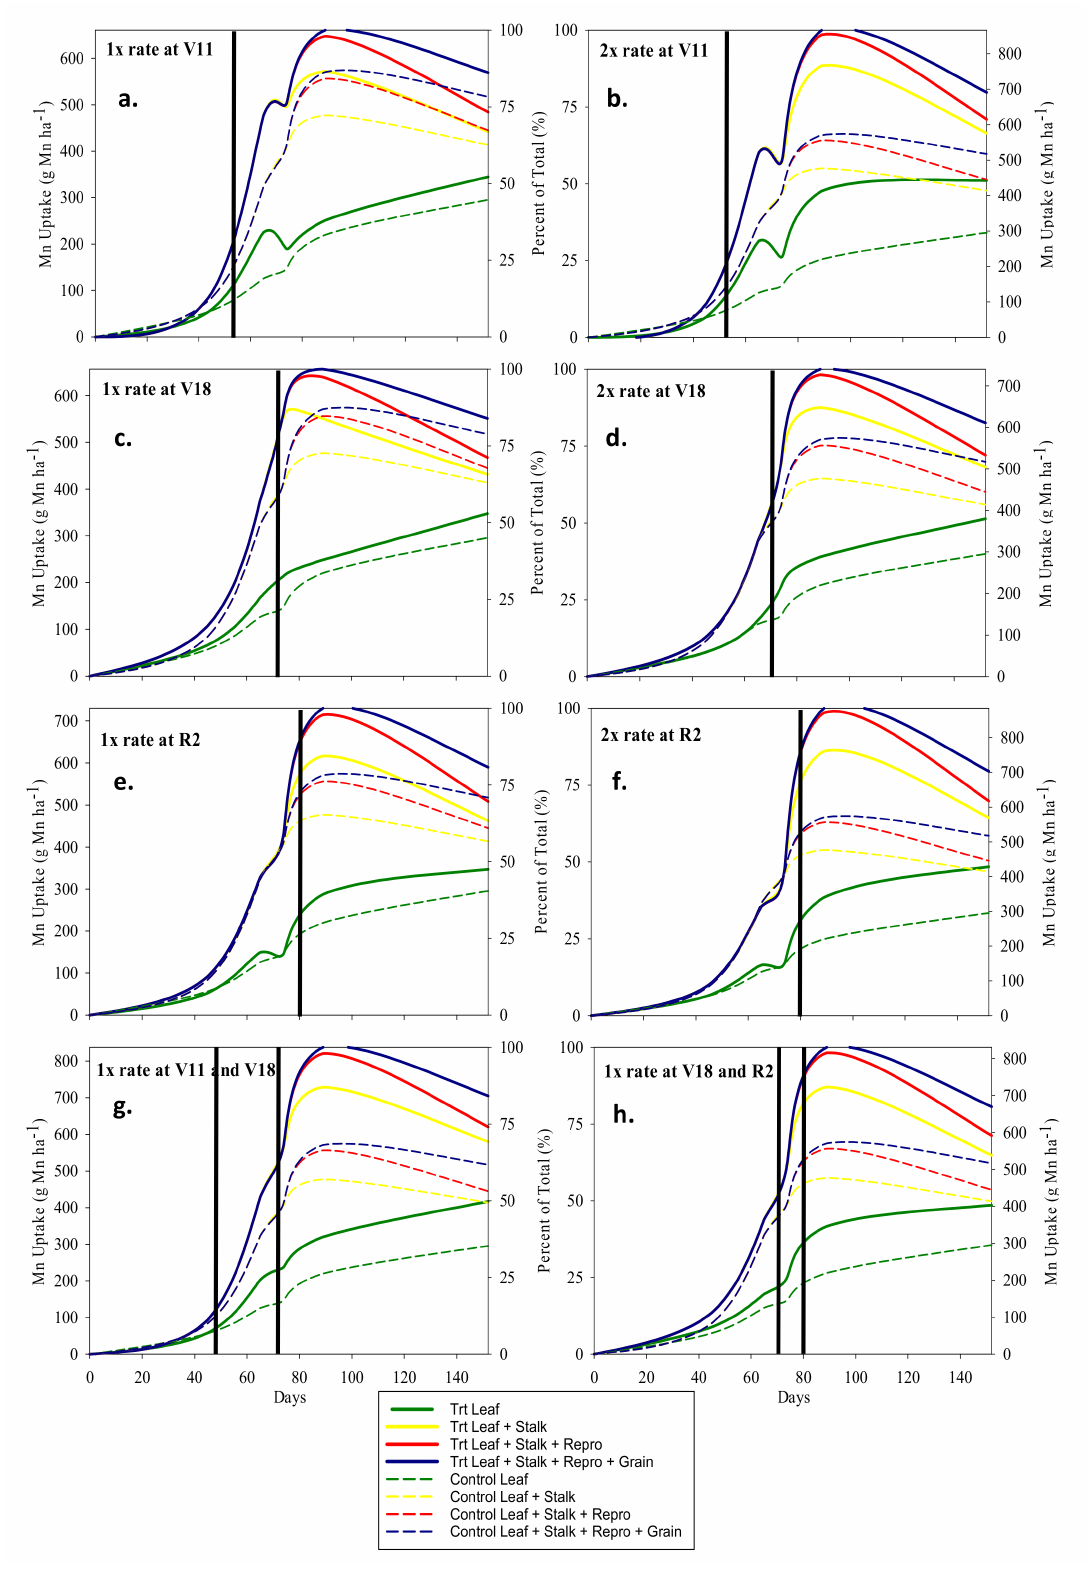
Figure 4. Mn uptake (g Mn ha − 1 ) and partitioning graphs. Solid and dashed lines represent foliar Mn treated plots and control plot, respectively. Solid vertical lines represent the time of application expressed as days after sowing. ( a – h ) corresponds with the